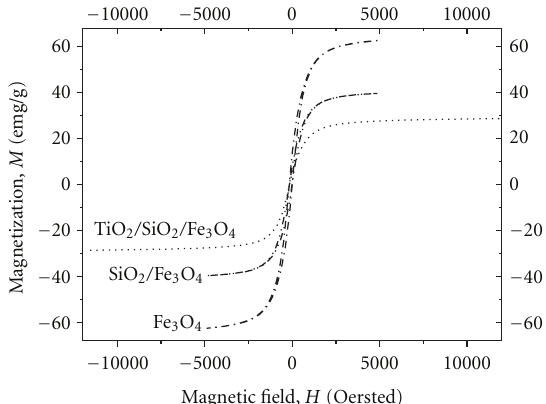
Figure 4: Magnetization versus applied magnetic field.